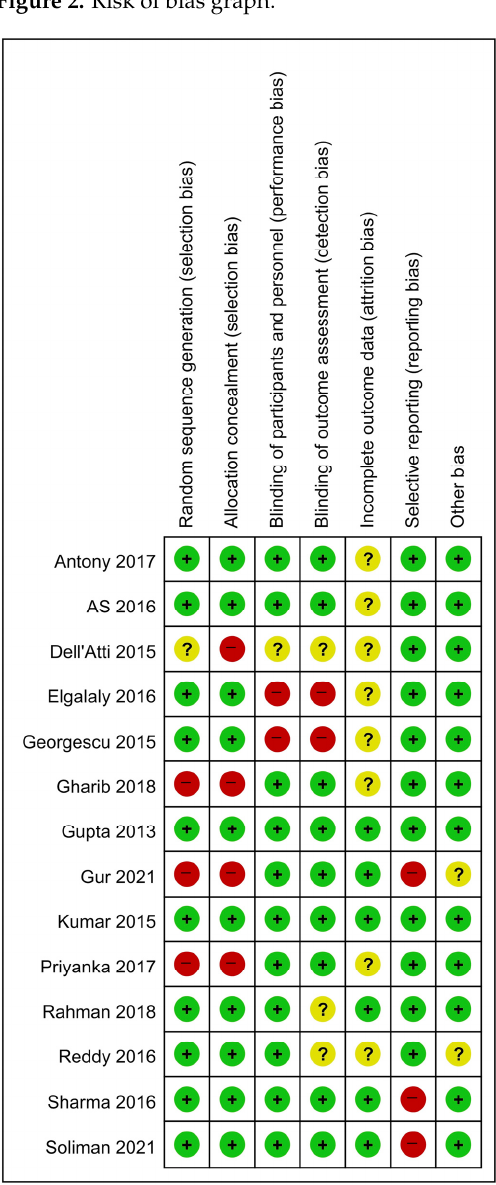
Figure 2. Risk of bias graph.